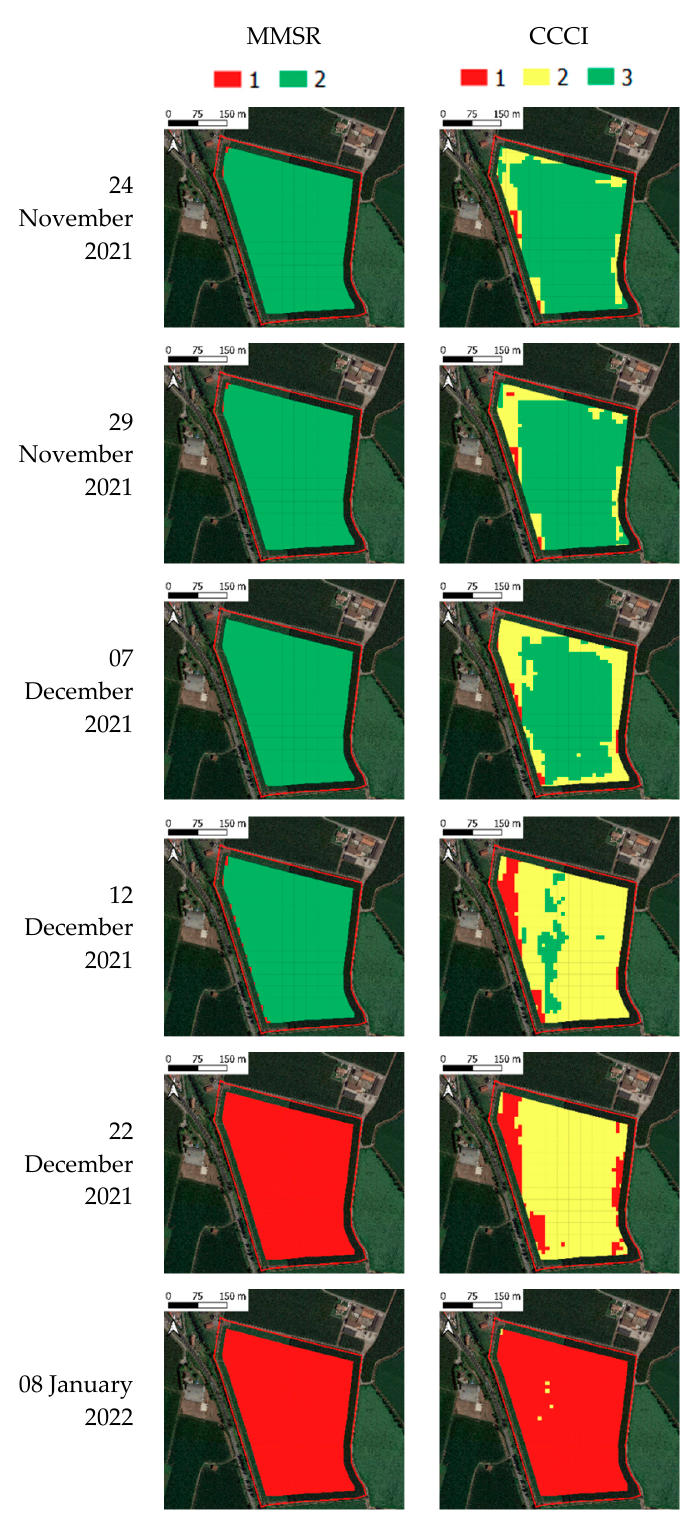
Figure 7. Maps of the results of the multi-temporal cluster analysis of two vegetation indices describing cover crop frost damage (MMSR and CCCI, Modification to Modified Simple Ratio and Canopy Chlorophyll Content Index) for the field in Ghedi. Clusters are mapped in increasing order corresponding to the value of the vegetation index of the center of the cluster. Clusters codified with lower values are those with higher frost damage. Clusters with the same code in different dates are characterized by similar values of the vegetation